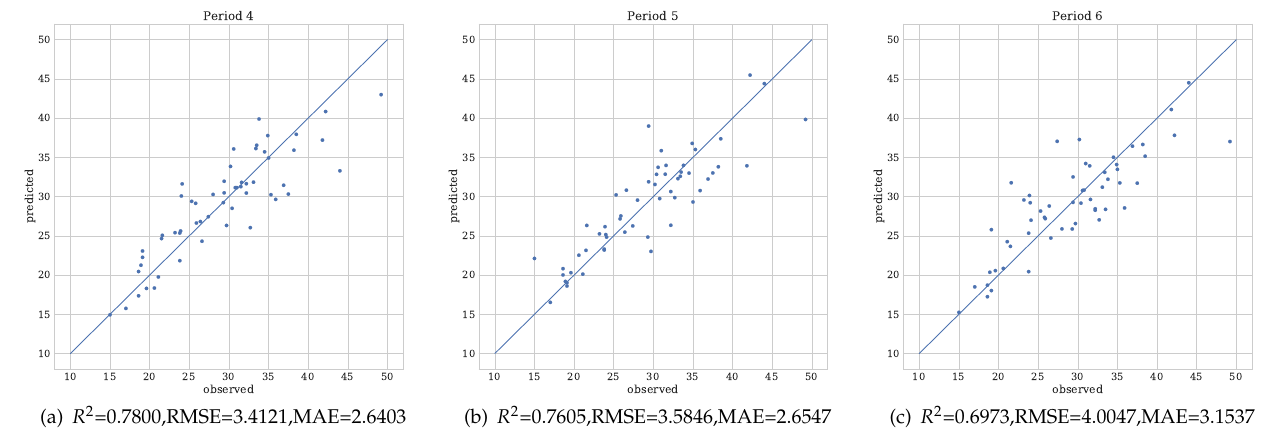
Figure 9. Scatter plots of observed versus predicted biomass values achieved by the integrated regression model.